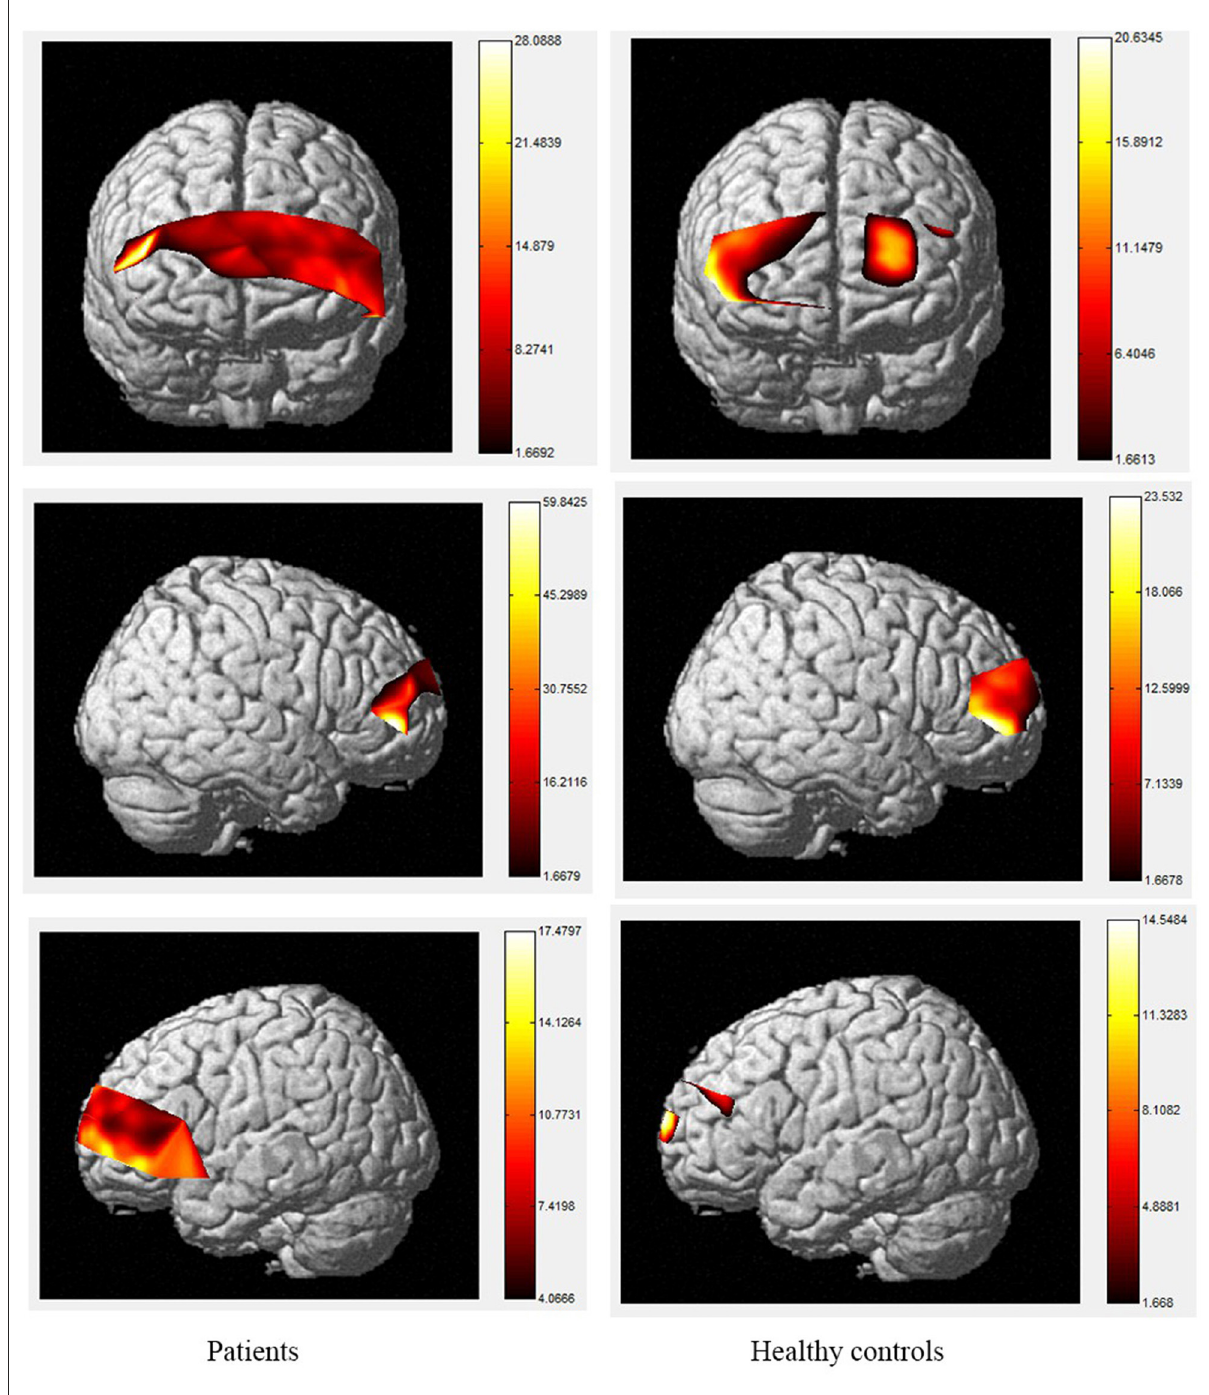
FIGURE5 The activation of brain areas during 2-back tasks between patients and healthy controls. The color bars in right sides mean the activated strength of brain areas.